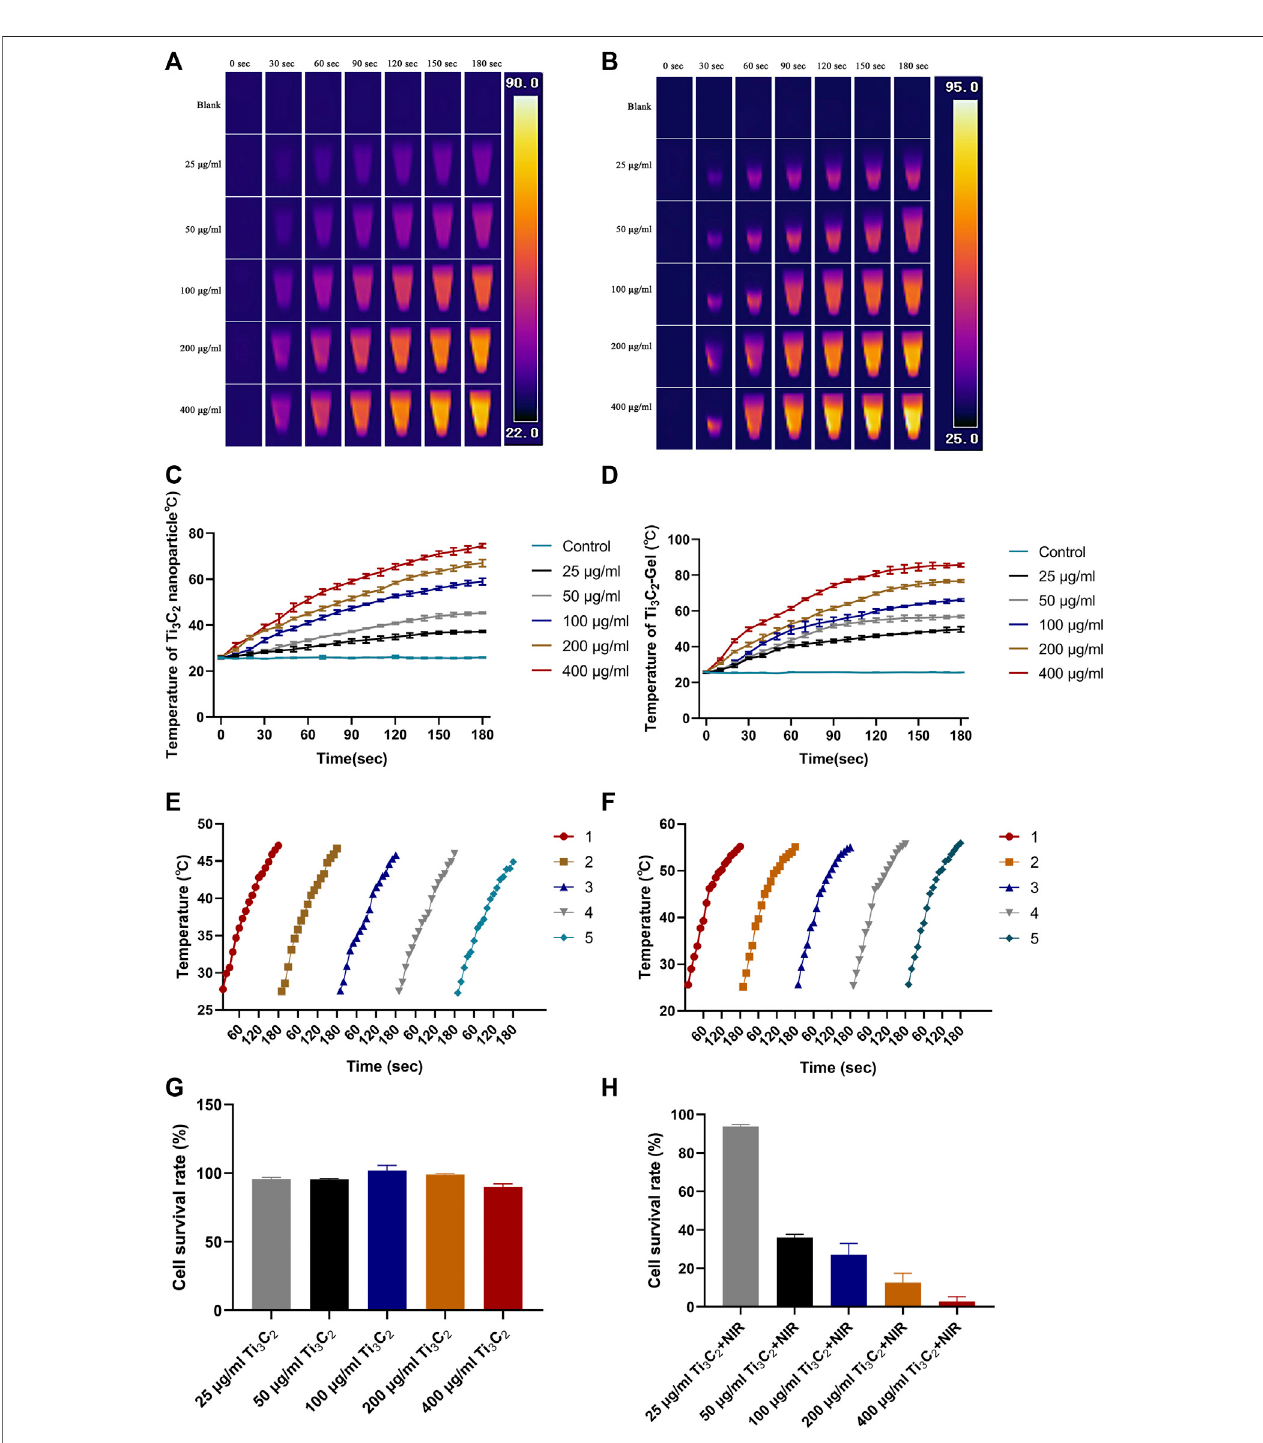
FIGURE 4 | In vitro photothermal performance. (A,B) Temperature diagram of Ti 3 C 2 nanoparticles and Ti 3 C 2 -Gel under 808-nm irradiation (1 W/cm 2 ). (C,D) Heating curve of different concentrations of Ti 3 C 2 nanoparticles and Ti 3 C 2 -Gel under 808-nm irradiation (1 W/cm 2 ). (E,F) Heating curves of Ti 3 C 2 nanoparticles and Ti 3 C 2 -Gel treated with repeated 808-nm irradiation (1 W/cm 2 ). (G) Viabilities of 4T1 cells incubated with different concentrations of Ti 3 C 2 nanoparticles in DMEM media for 12 h. (H) Cytotoxicity of Ti 3 C 2 nanoparticles against 4T1 cells exposed to the 808-nm NIR laser (1 W/cm 2 ) for 1 min ( n (cid:2) 4/group).